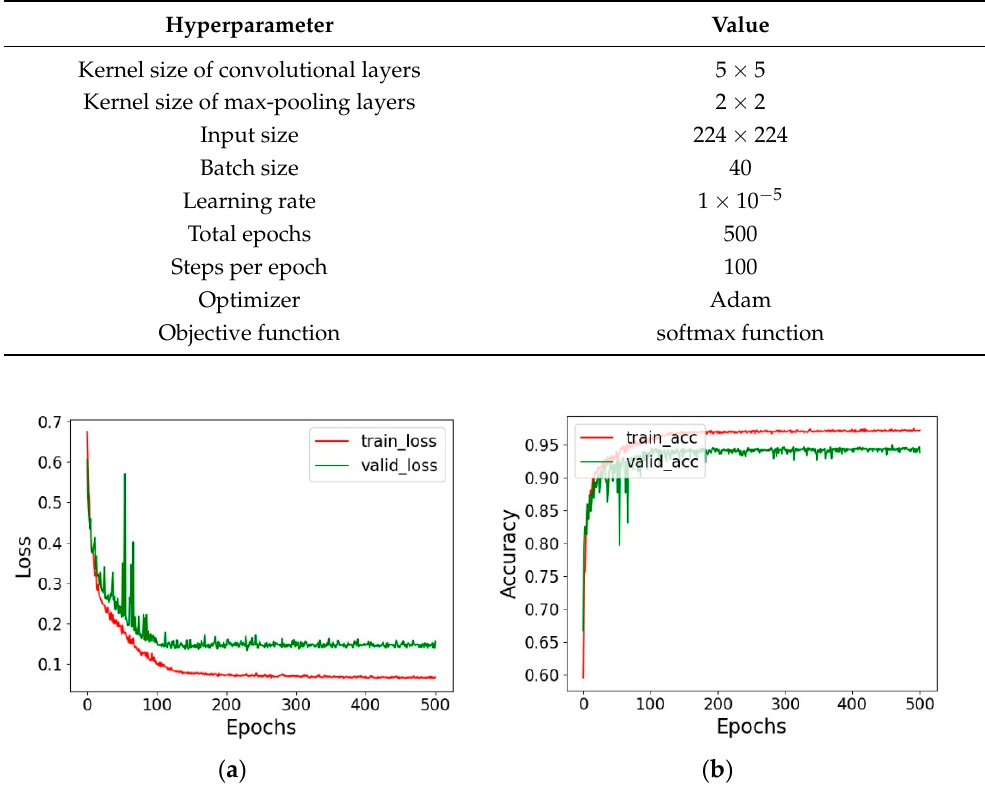
Figure 5. Training and validation results of CNN-based traffic accident classifier. ( a ) Loss of CNN-